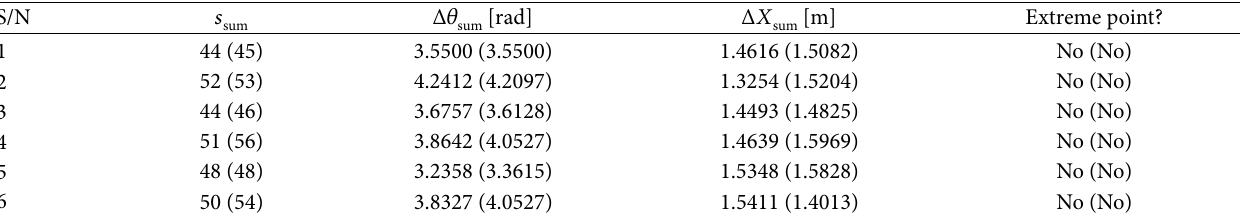
Table 5: Comparison of data between two planning methods for an obstacle.